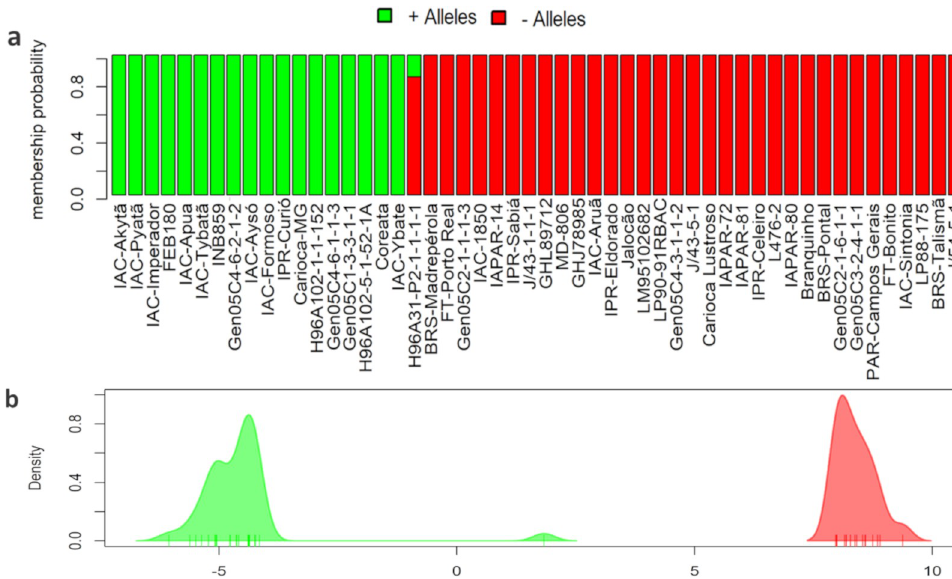
Fig 5. Discriminant analysis of the principal components (DAPC) carried out using the simple nucleotide polymorphisms (SNPs) associated with resistance to anthracnose classified by the resistance allele. (a) Compoplot showing clustering performed only with the 52 accessions considered resistant to all races (i.e., score � 3), both groups being formed based on the frequency of resistance and susceptibility alleles, in green and red, respectively. (b) Graphical representation of the separation of both groups, showing the absence of overlapping for discriminant